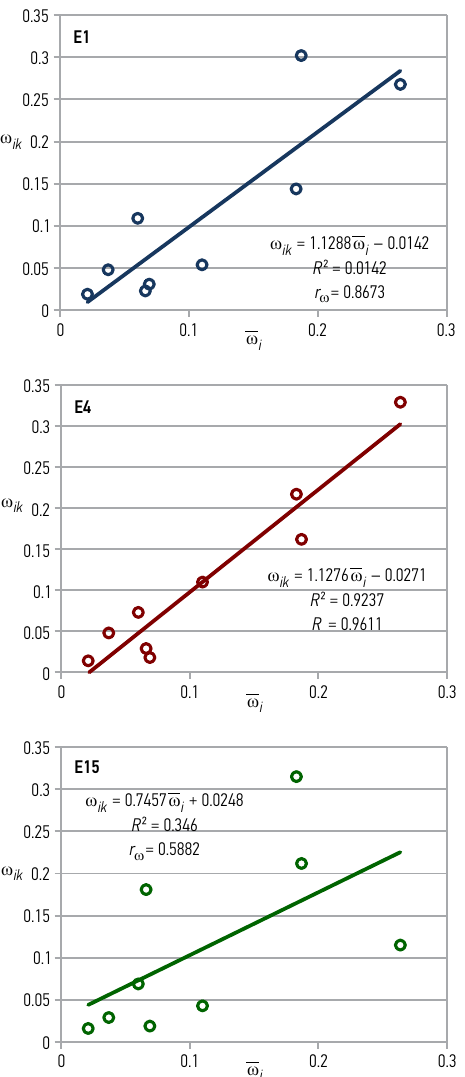
Fig. 3. The relationship between weights ω to the relationships of 9 TS elements (criteria) by individual experts (E1, E4, E15) and the average weight of criteria ω